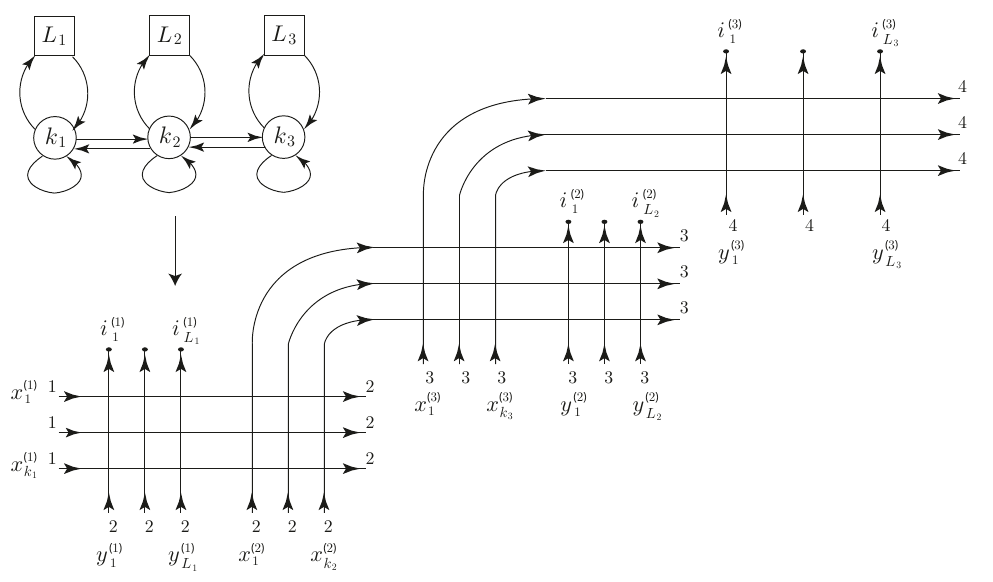
Figure 7 . An su (4) lattice configuration with s 1 = 2 , s 2 = 1 which describes the orbifold de- fect (5.29) for the A 3 quiver. Here k 1 ≤ L 1 + k 2 , k 2 ≤ L 2 + k 3 , k 3 ≤ L 3 and i ( p ) ℓ = 1 , . . . , L p , p = 1 , 2 , 3 represent